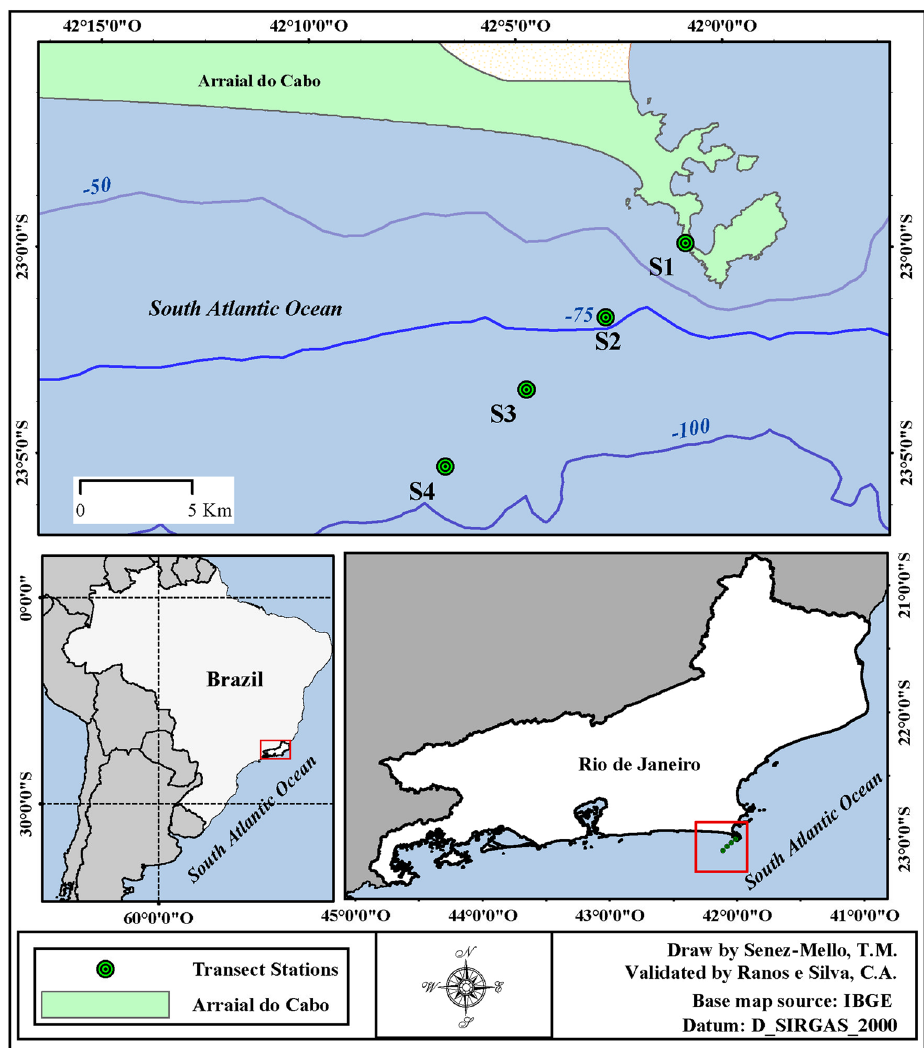
Figure 1. Study area. Sampling stations are represented by dots and respective numbers (S1, S2, S3, and S4). This map was generated with the ArcMap software v. 10.8.2 (https:// www. esri. com/ en- us/ arcgis/ about- arcgis/ overv iew), by Senez-Mello,